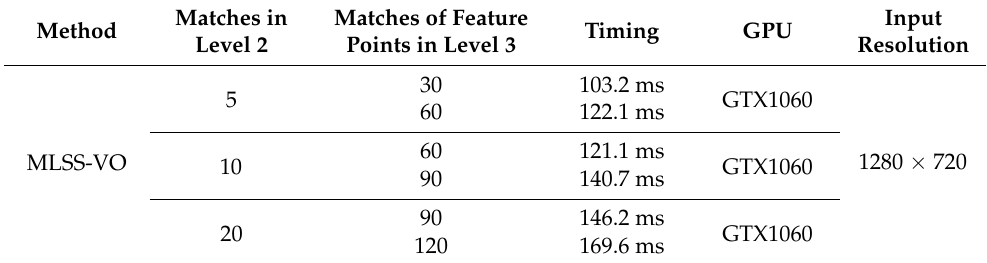
Table 2. Performance of timing for MLSS-VO in experiment 2.